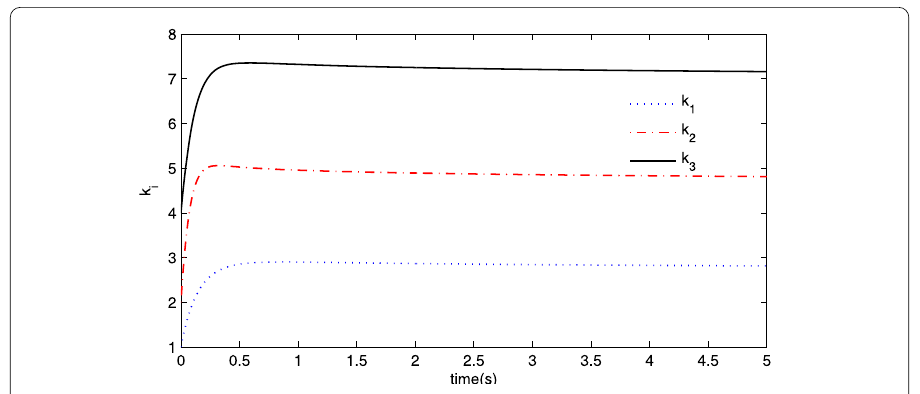
Figure 6 The evolution of the adaptive feedback